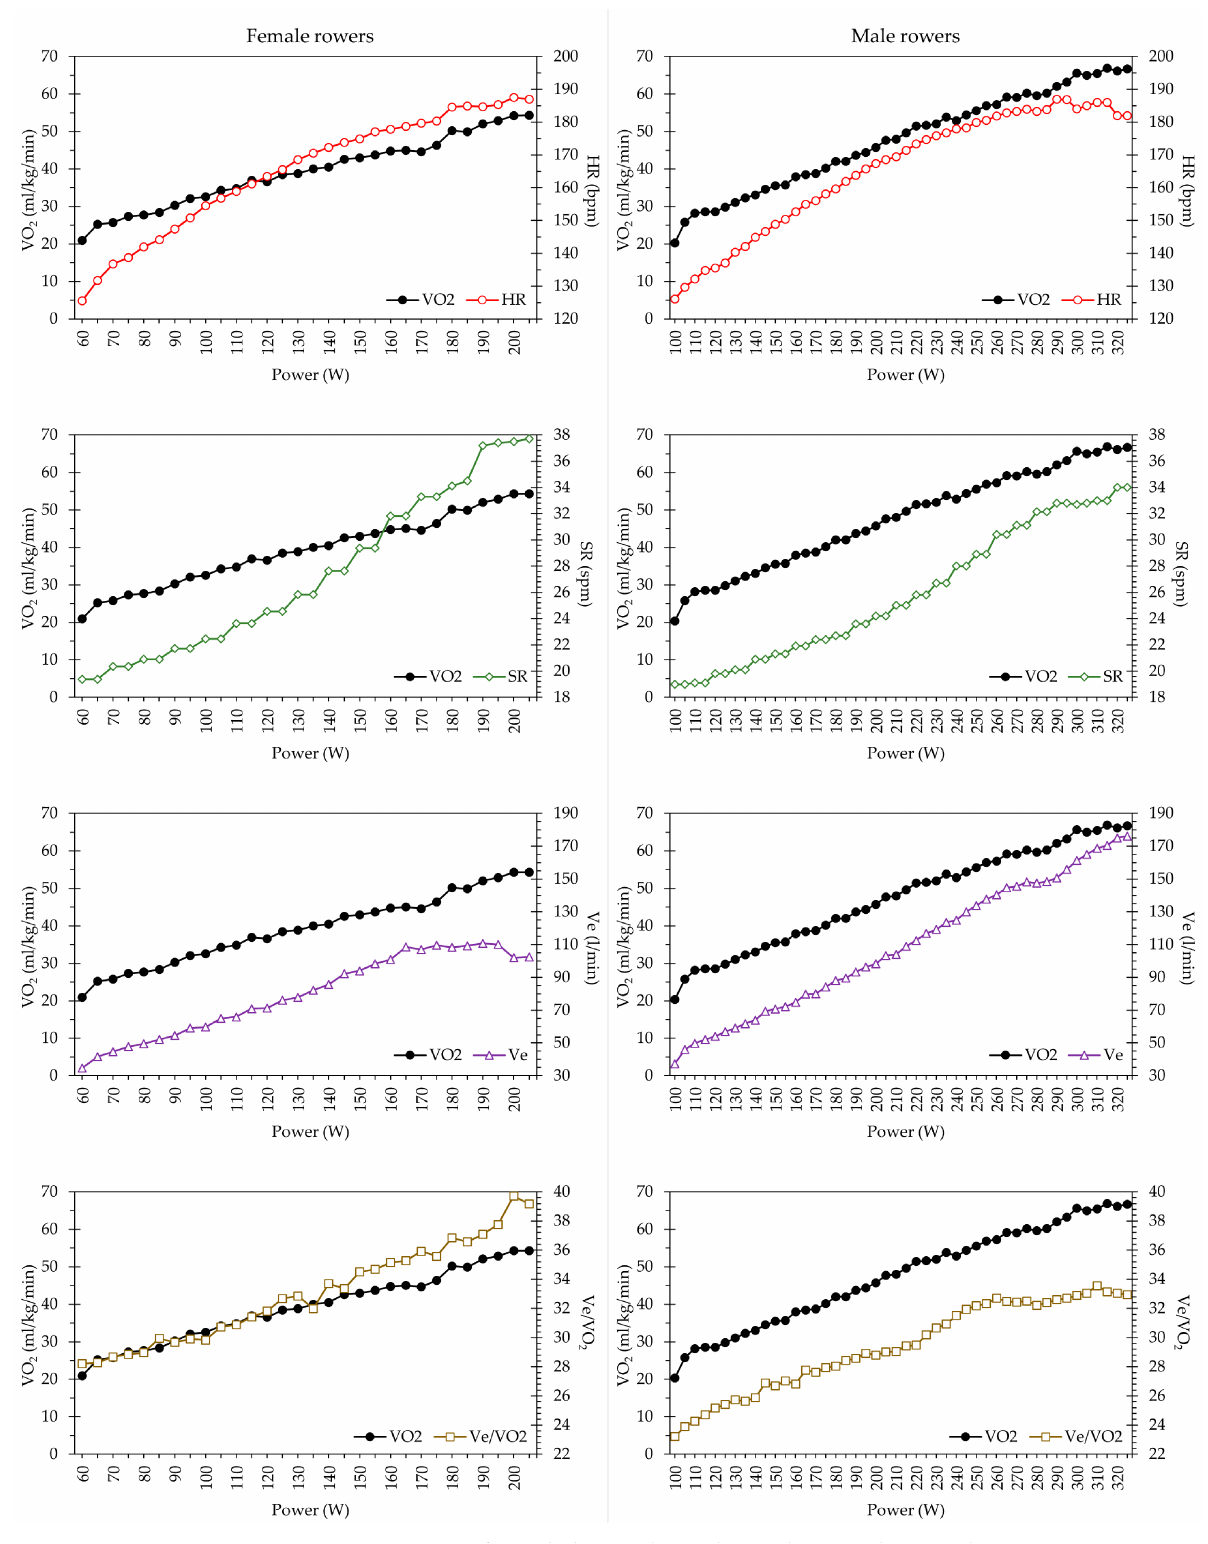
Figure 1. Kinetics of metabolic, mechanical, ventilator, and gas exchange parameters in a grade exercise test on a rowing ergometer.